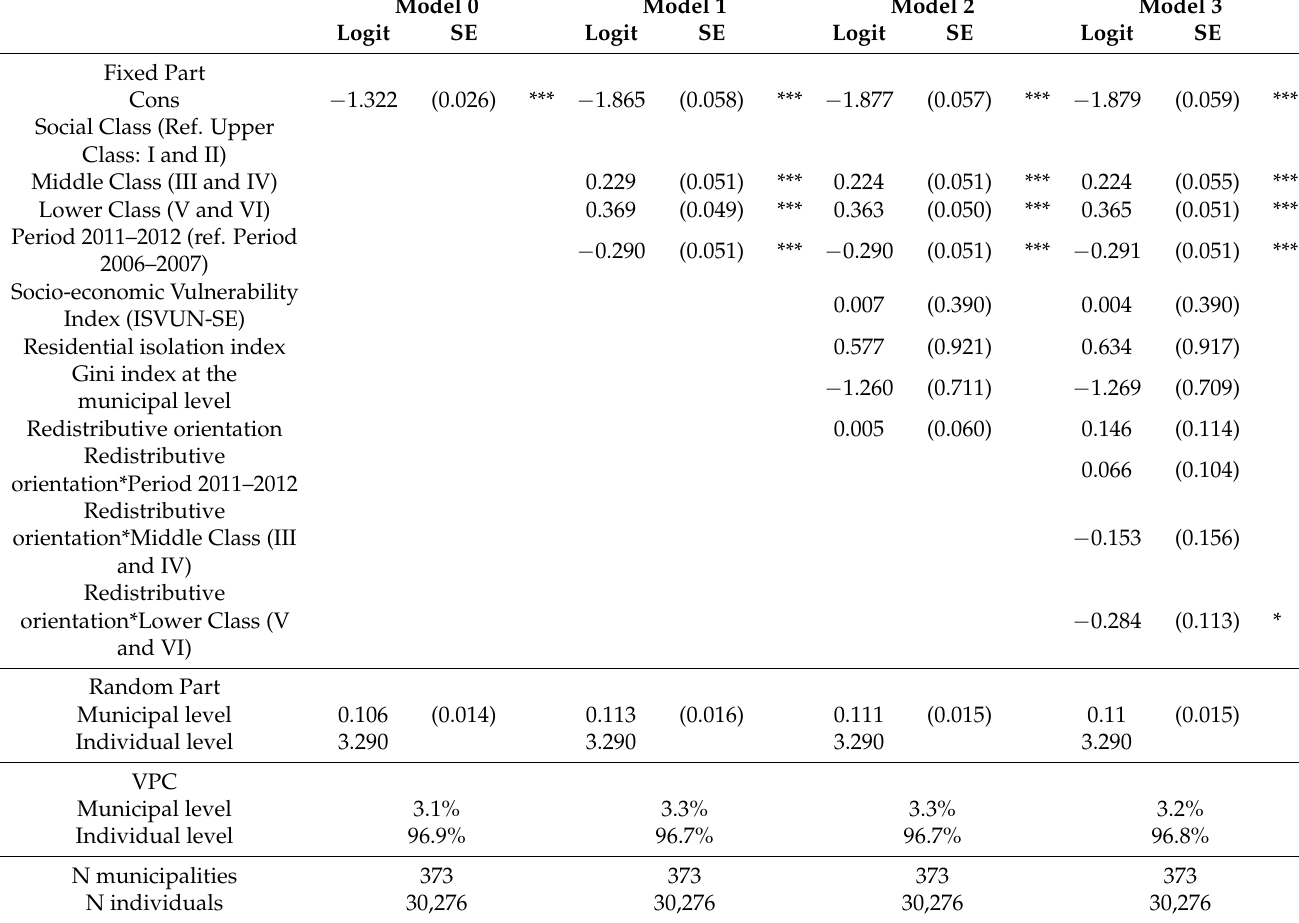
Table 3. Multilevel models for activity limitations due to health